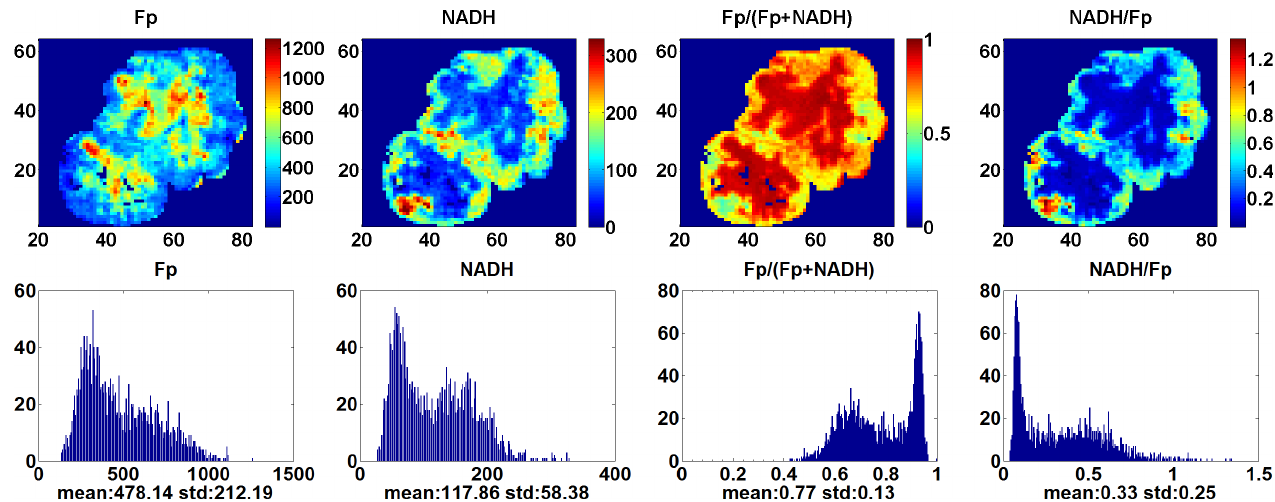
Fig. 3. Typical images and corresponding histograms of the smallest tumor in the p53 (cid:1) = (cid:1) group. The spatial resolution is 200 (cid:1) m and the section depth is 2700 (cid:1) m .